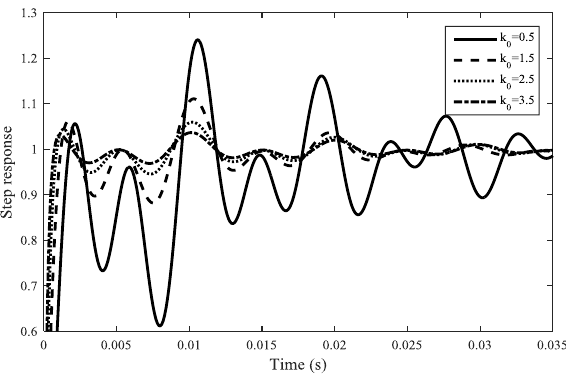
Figure 13. A resonant controller’s response vs. 𝑘 0 .